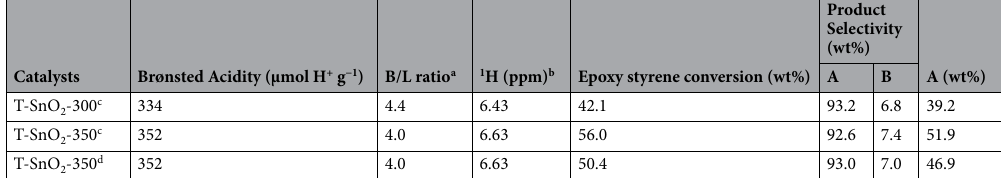
2 -300, A = 2-methoxy-